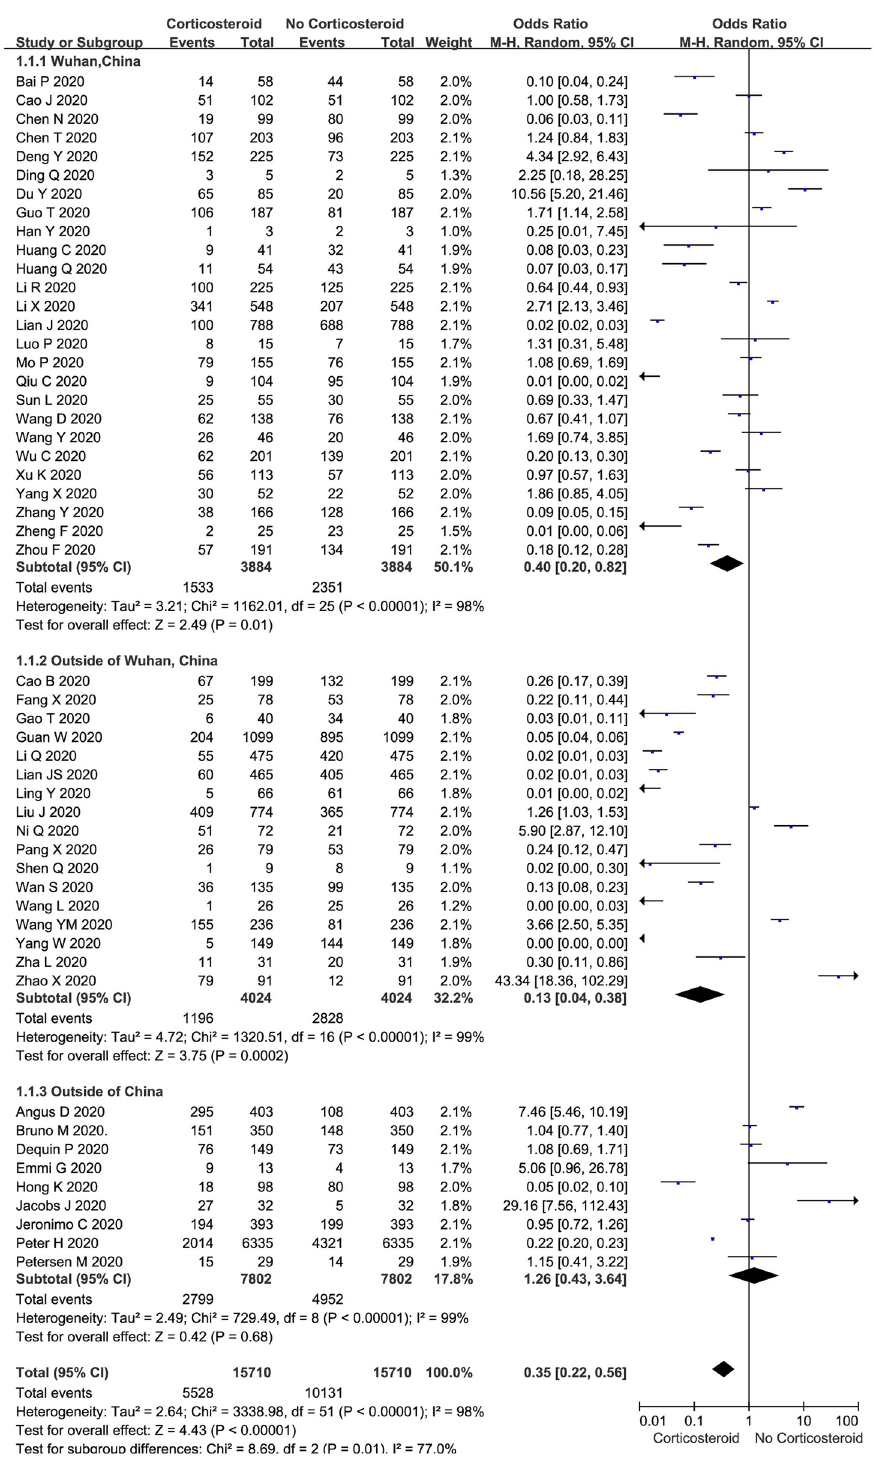
Fig 2. Proportion of corticosteroid treatments in COVID-19 patients: Overall and subgroup analyses stratified by region.